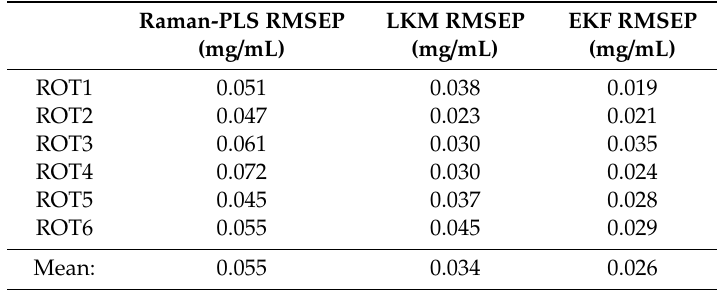
Table 6. Prediction errors of the Raman-PLS, the LKM and EKF model for all rotations. Raman-PLS